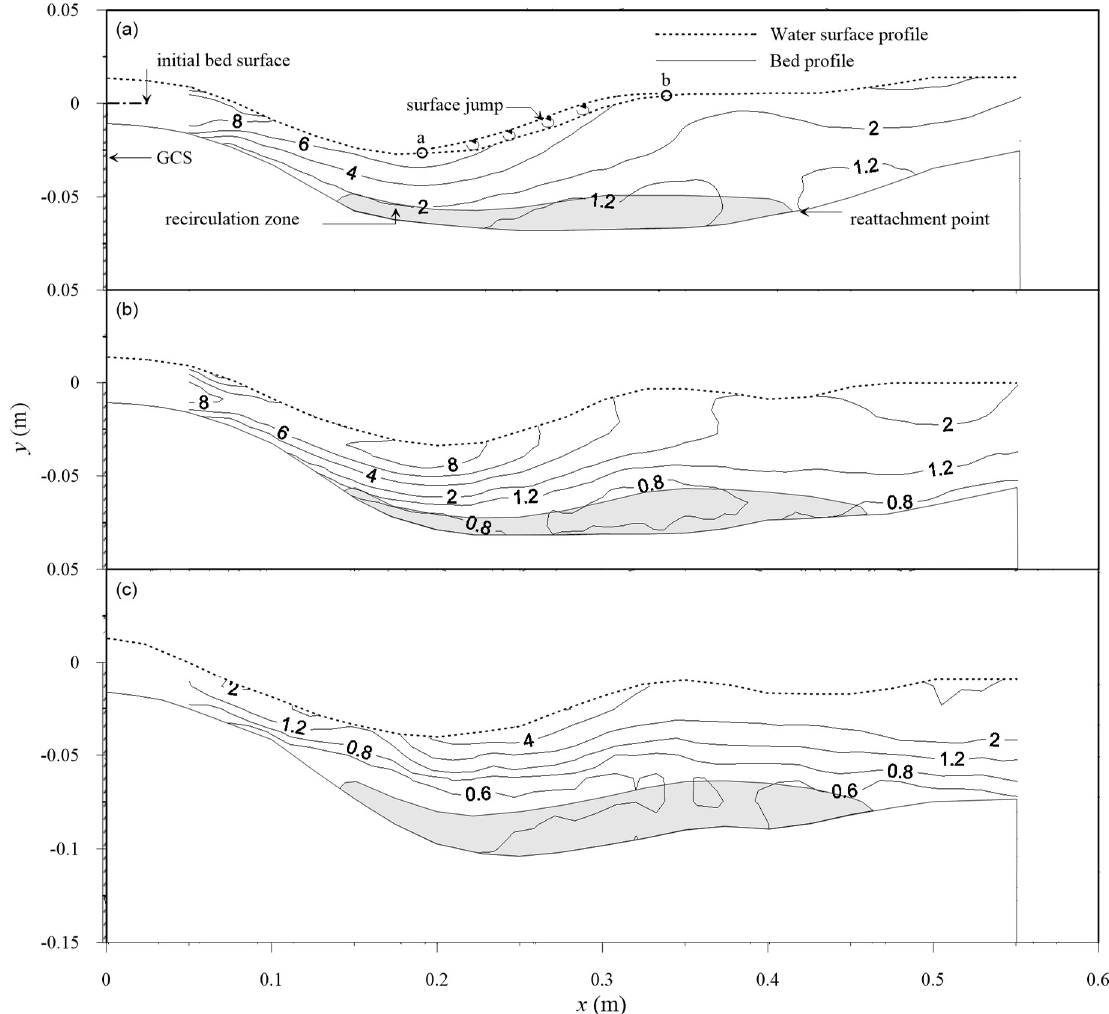
u ) contours in the scour *